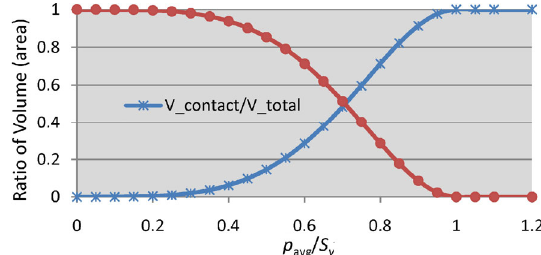
Fig. 12 Ratio of fluid area and asperities area versus p avg .